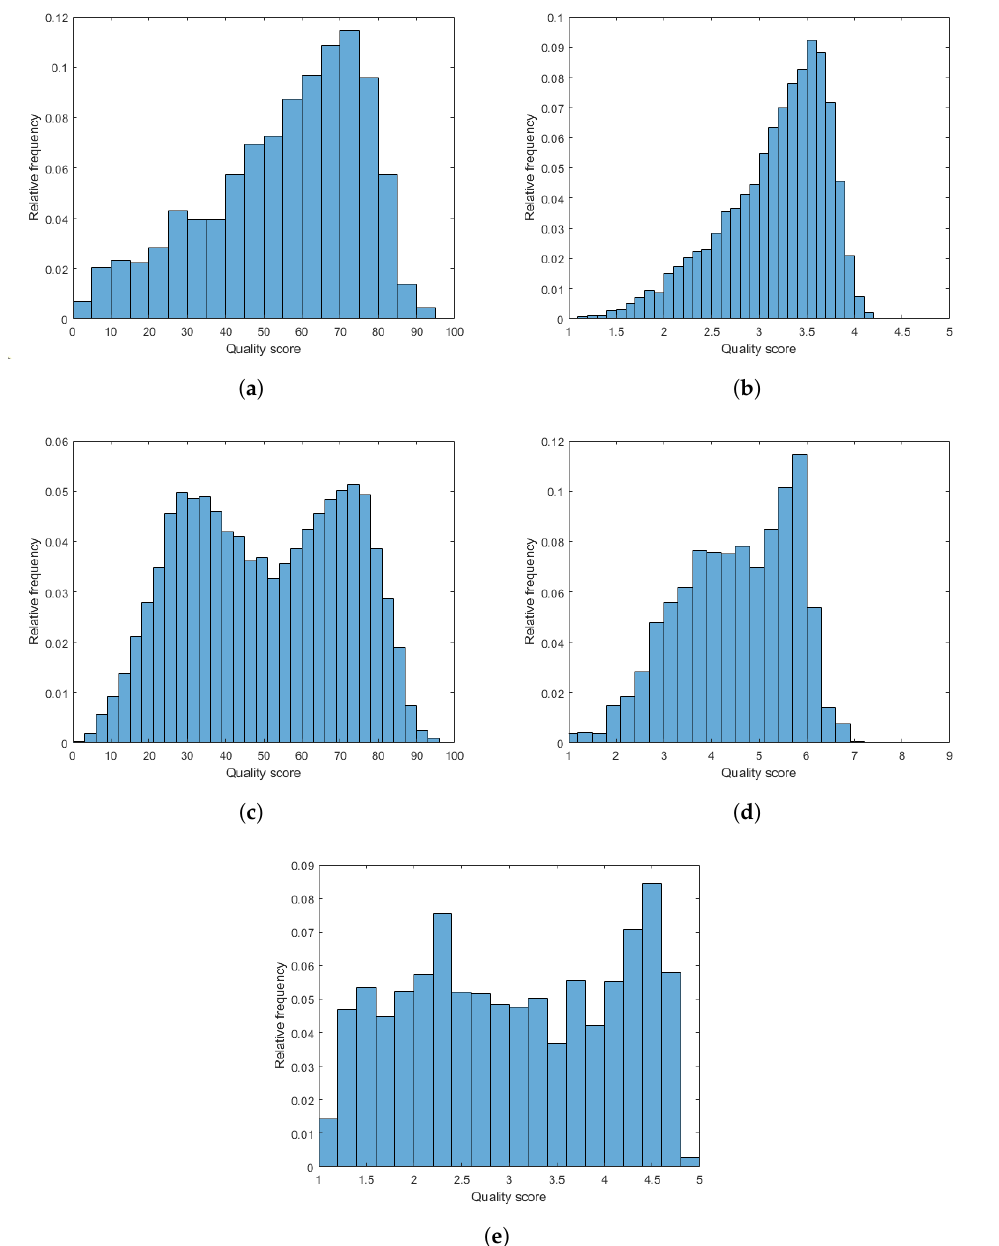
Figure 1. The empirical distributions of quality scores in the applied IQA databases. ( a ) CLIVE [21], ( b ) KonIQ-10k [22], ( c ) SPAQ [23], ( d ) TID2013 [24], ( e ) KADID-10k